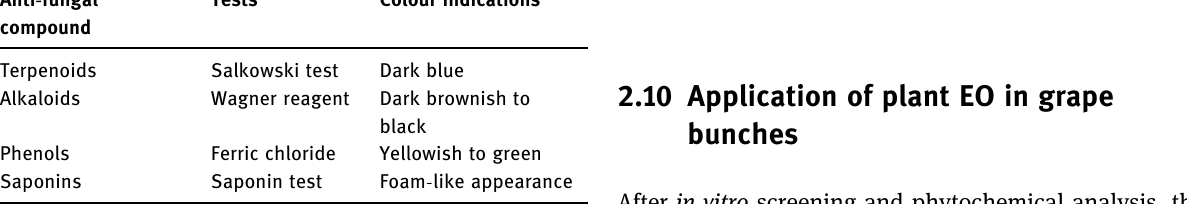
Table 2: Antifungal compounds, tests, and colour indications Anti - fungal